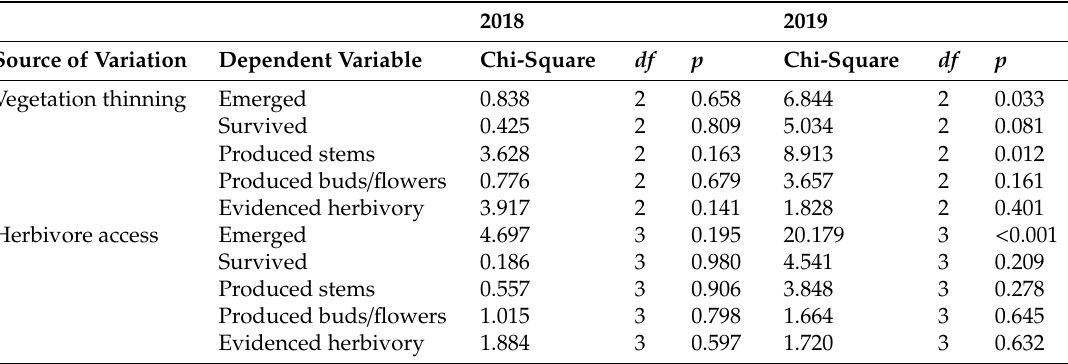
Table 1. Results of chi-square analyses to test the influence of vegetation thinning and vertebrate herbivore access on the numbers of Platanthera integrilabia individuals that emerged from tubers planted in early 2018 and 2019 in a forested study site in the Bridgestone–Firestone Centennial Wilderness, TN, USA and the number of emerged plants that survived, produced stems, produced buds or flowers, and evidenced herbivory during the subsequent growing